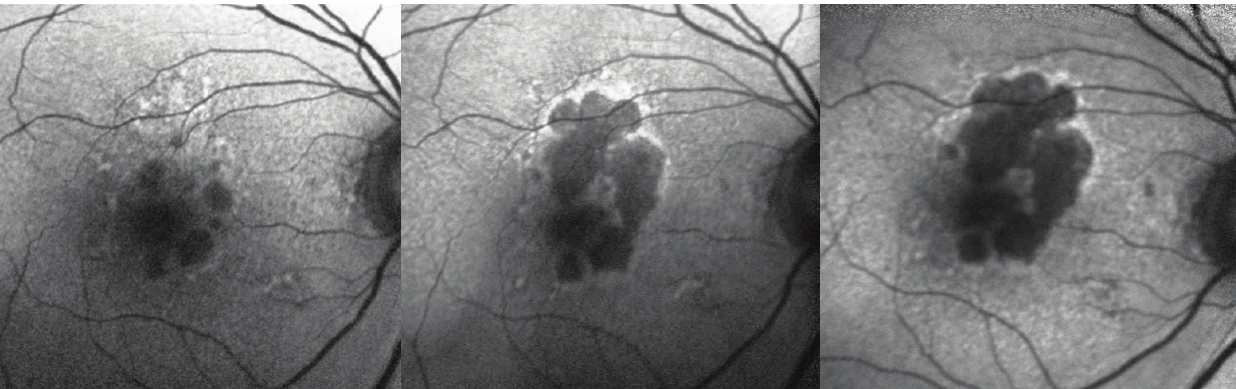
Figure 4. Progression of dry age-related macular degeneration on blue light (Spectralis) fundus autofluorescence (FAF). Left: Right eye of a patient with geographic atrophy (GA). Note the hypoautofluorescent (hypo-AF) patches with superior hyperautofluorescent (hyper-AF) lesions. Middle panel: Progression of the GA superiorly into the area of previous hyper-AF. Note the hyper-AF border of the GA indicating areas of disease activity. Right: Further progression of GA, primarily at the edges with prior